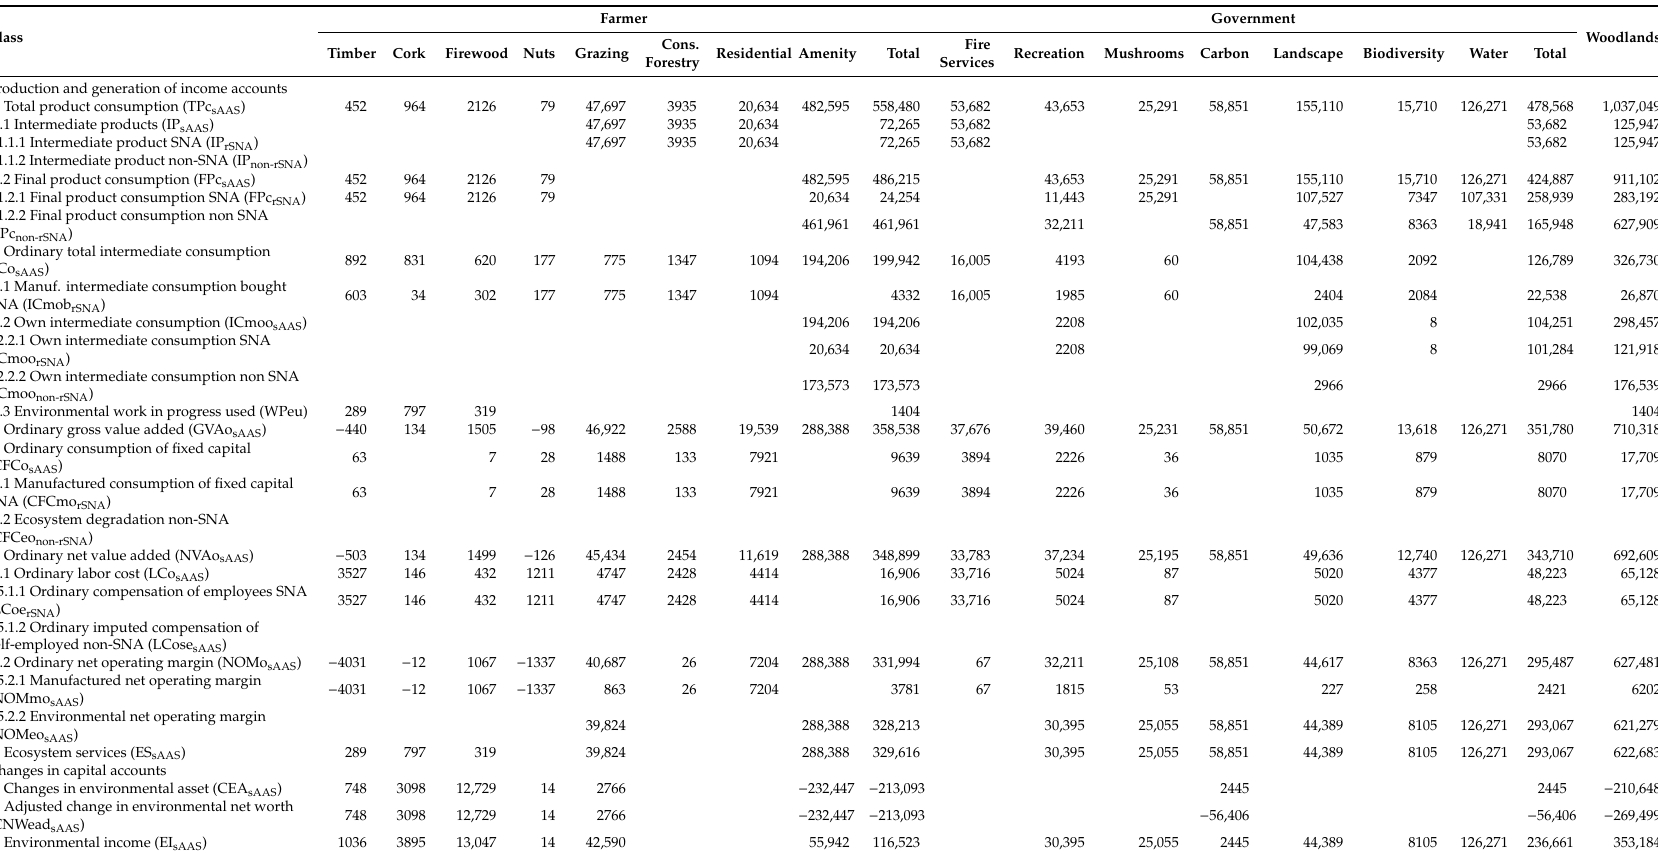
Table A1. Stylized sequence of accounts of the simplified Agroforestry Accounting System applied in holm oak open woodlands in Andalusia, Spain (2010: thousands of